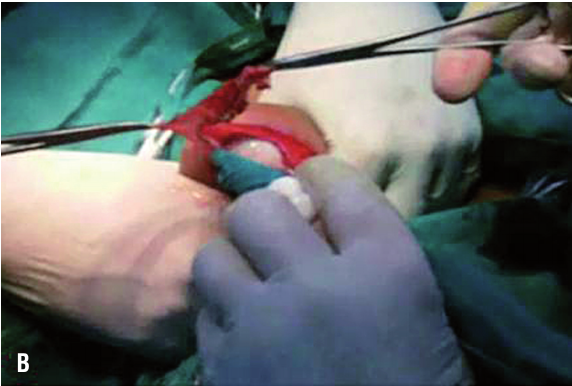
Figure 2A - An operative photograph showing evacuation of hydrocele fluid through a small hole made in the tunica vaginalis.